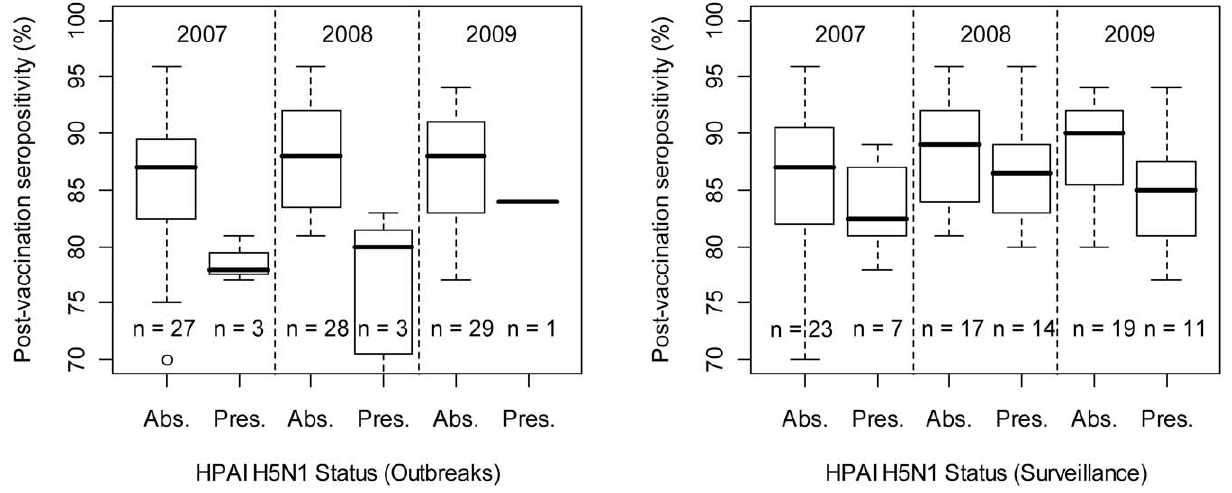
Figure 5. Province-level percentage of post-vaccination sero-positivity as a function of disease/infection status. The left and right plots are based on reported HPAI H5N1 clinical disease outbreak data and HPAIV H5N1 risk-based surveillance data, respectively.